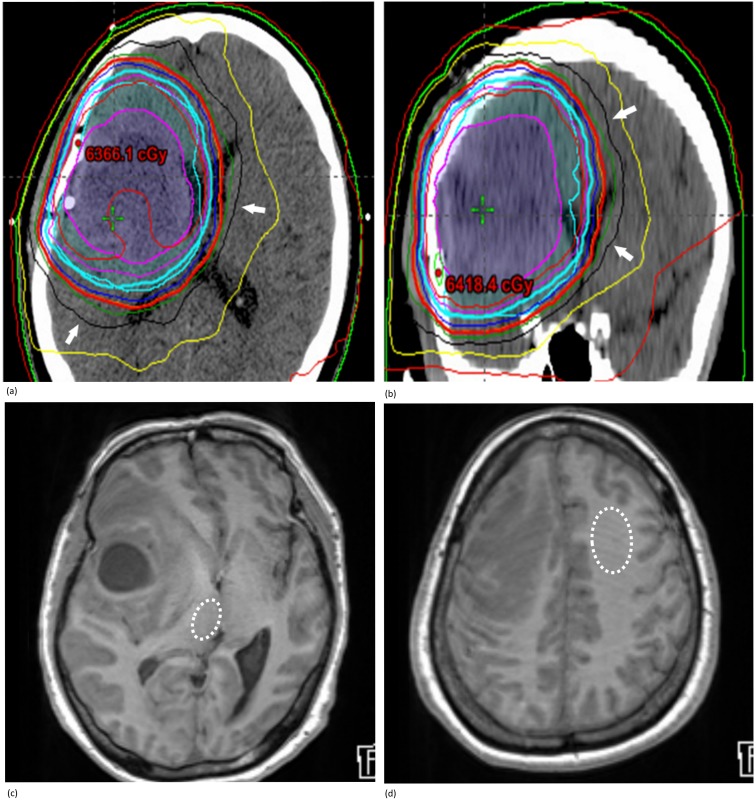
Definition of AreaH and AreaL.A 58-year-old female patient underwent radiotherapy for the treatment of GBM located in the right frontal lobe. The radiotherapy plan map was obtained from the electronic medical records system (EMR) and was composed of representative (a) axial, (b) coronal, and sagittal (not presented) CT images (note; arrows represent the iso-dose line of 3600 cGy). In this patient, (c) the right thalamus (dashed circle) was designated as a AreaH, whereas (d) the left frontal white matter (dashed circle) was considered a AreaL (presented images: pre-contrast T1WI).